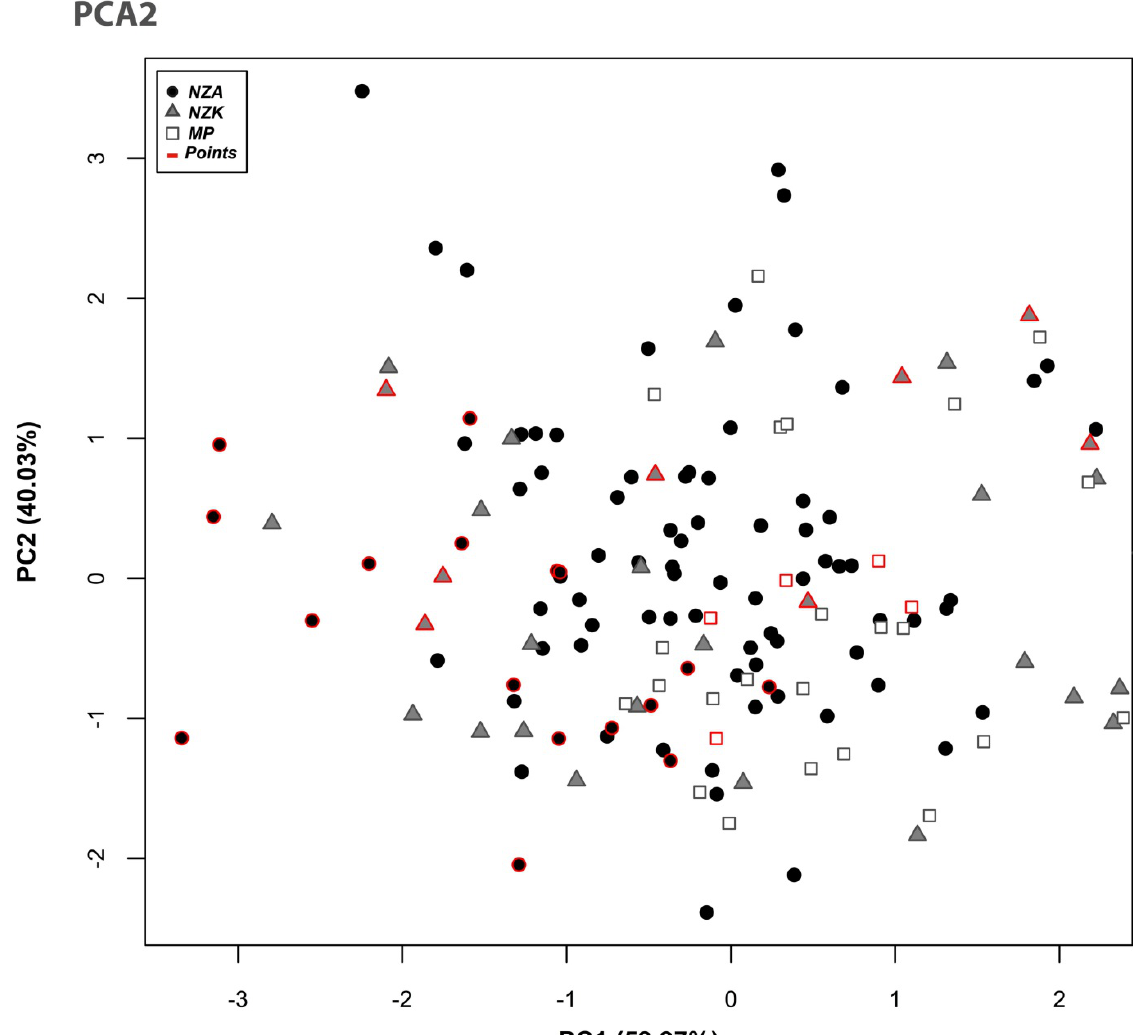
Figure 12. PCA2 - Plot of the PCA scores of the two PCs. PCA is realised on the three LSR variables. The results for this PCA are in Table 6 and concern the whole assemblages. Symbols represent sites (circles: NZA, triangles: NZK, squares: MP) and red outlines indicate